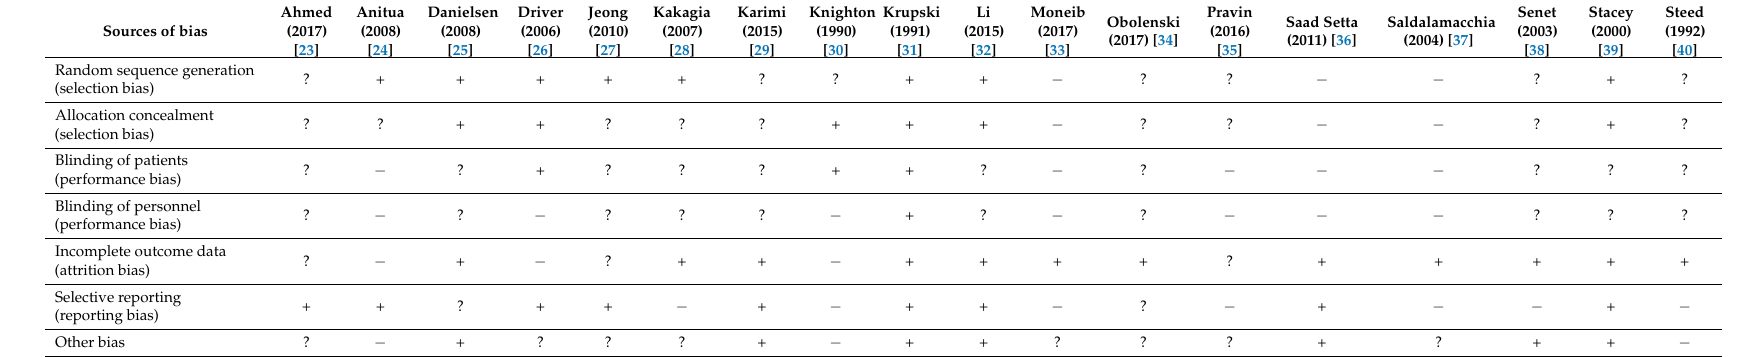
Table 4. Risk of bias summary for PRP studies.